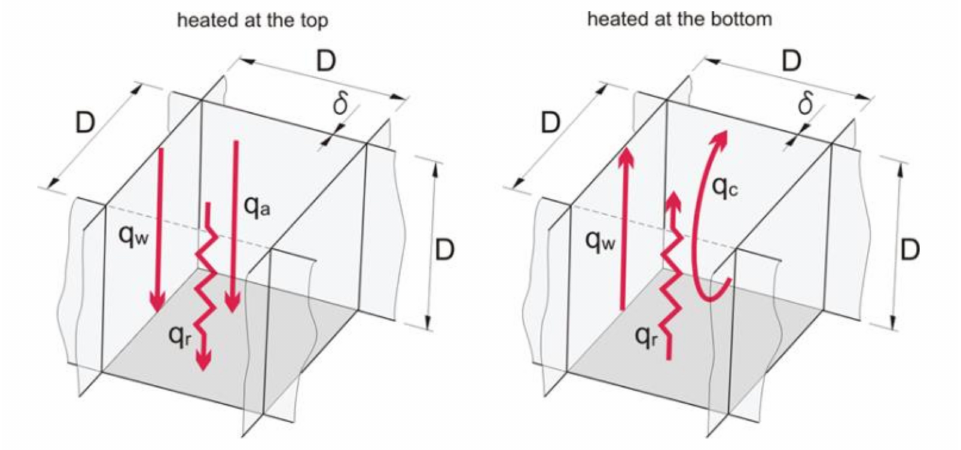
Figure 4. Diagram of the processes of heat exchange that occur in the air partition, using the example of the quadrangle structure